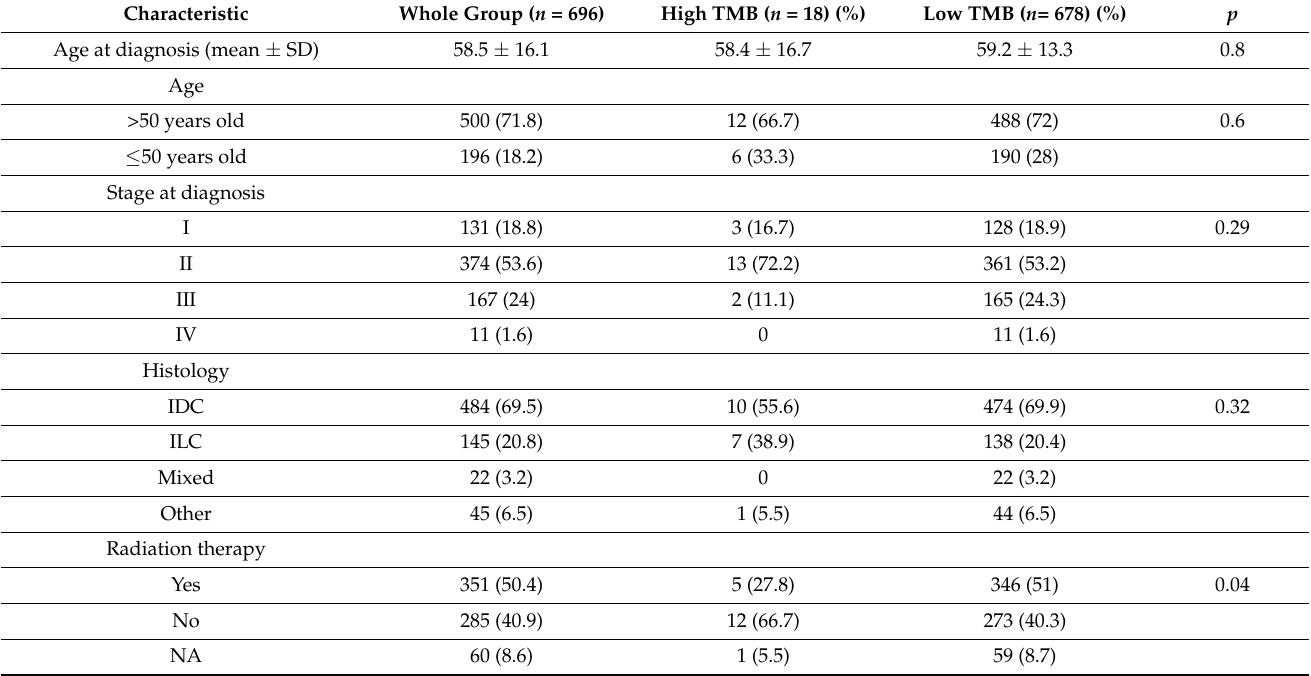
Table 1. Characteristics of the high and low TMB groups in patients with luminal cancers from the breast cancer TCGA study. In parentheses are percentages. Stage was not available in 13